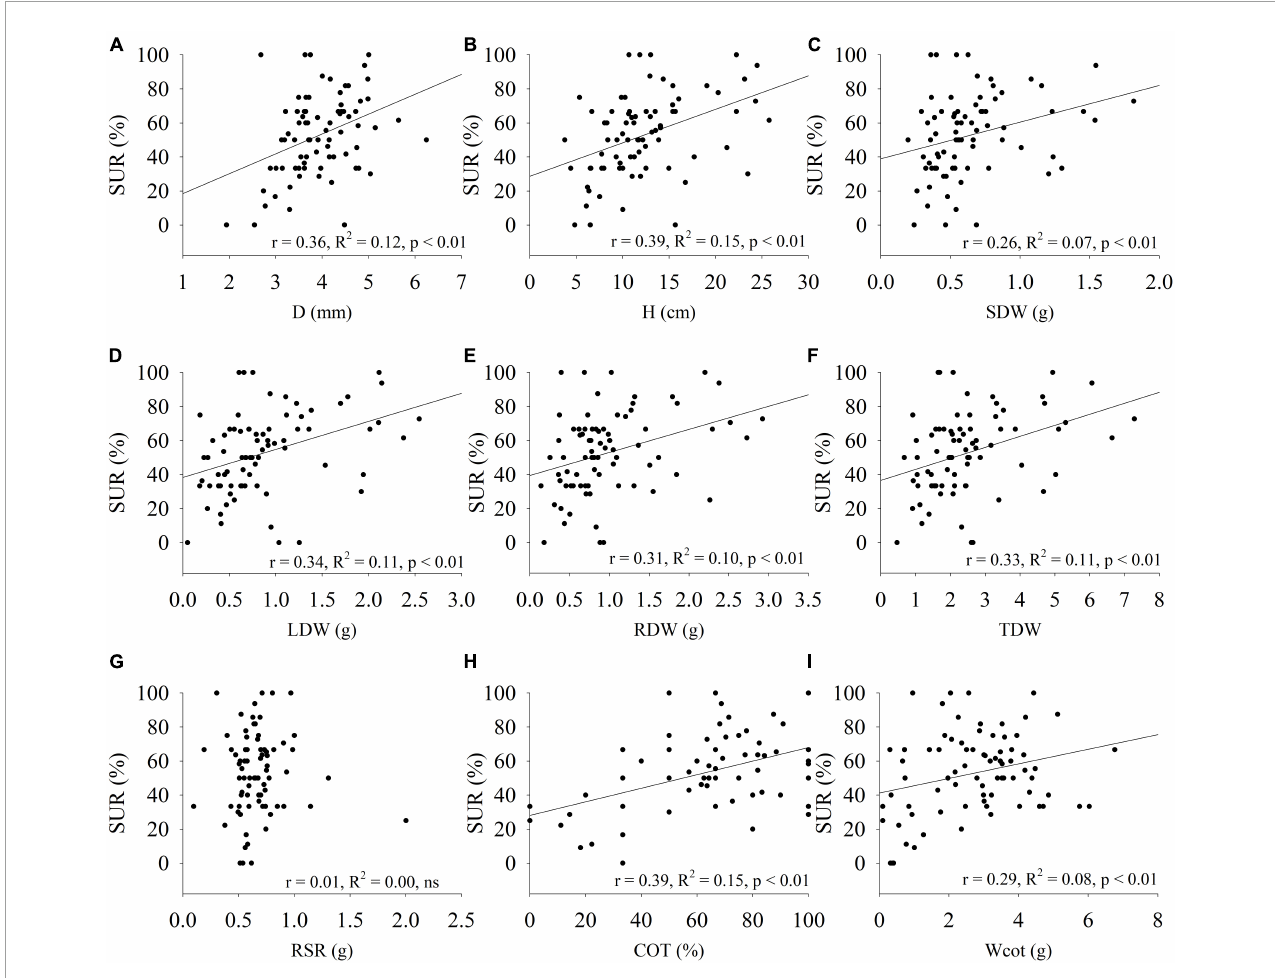
FIGURE3 Relationship among the seedling survival with seedling traits of Beilschmiedi miersii in the WS treatment in provenances Cantillana and El Arbol. Regressions were conducted with average family values in a replicate. (A) D, root collar diameter; (B) H, height; (C) SDW, stem dry weight; (D) LDW, leaves dry weight; (E) RDW, root dry weight; (F) TDW, total dry weight; (G) RSR, root to shoot ratio; (H) COT, percentage of cotyledons; and (I) Wcot, weight of the cotyledon.